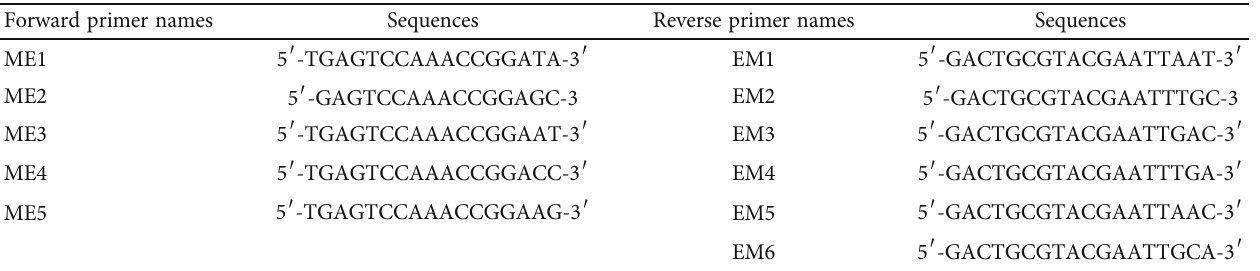
Figure 1: Geographic locations of the seven provinces where Alternaria sp. isolates were collected: 1 — Larache, 2 — Kénitra, 3 — Sidi Slimane, 4 — Salé, 5 — Khémisset, 6 — Beni Mellal, and 7 — Agadir. Table 2: Forward and reverse sequences of SRAP primers used in this